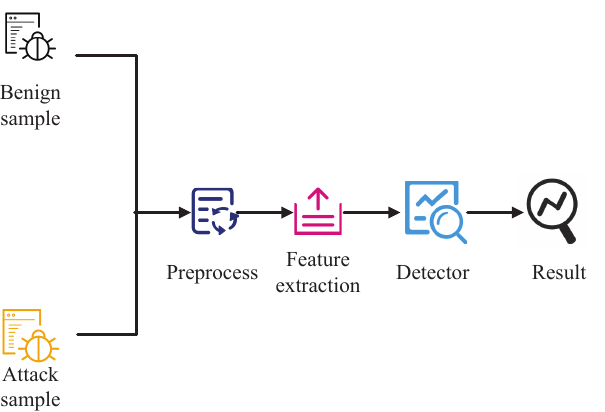
Figure 6. The framework of the detection method.